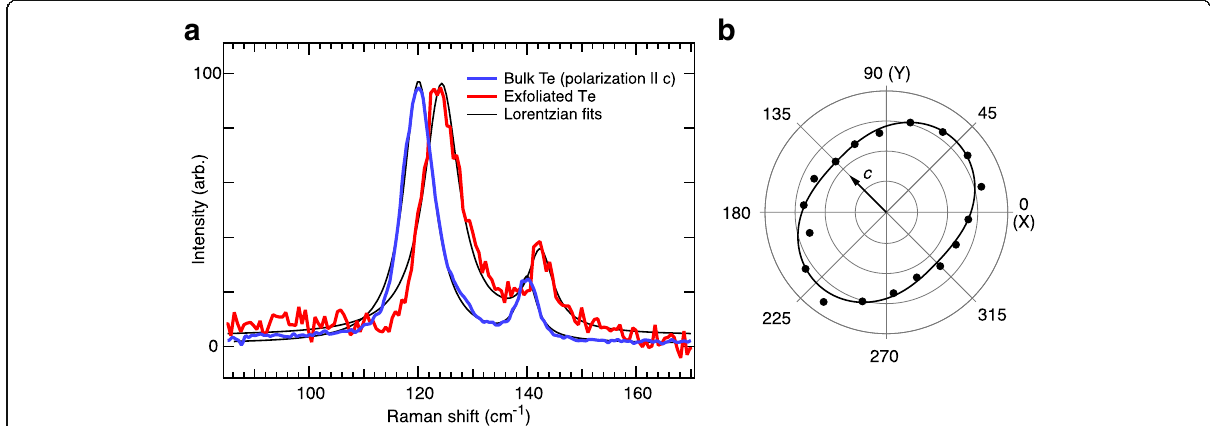
Fig. 4 a Raman scattering spectrum of bulk Te crystal ( blue ) and an exfoliated flake ( red ), under the same excitation conditions (633 nm, polarization parallel to c -axis). Spectra are normalized to the height of the dominant A1 peak. Fits ( black curves ) are a sum of two Lorentzians. b Polar plot of Raman intensity averaged over the spectral range in ( a ) as a function of linear excitation polarization angle relative to the c -axis (plot origin is zero intensity). The fit is a sine function plus a constant. The black arrow indicates the c -axis direction (see text)